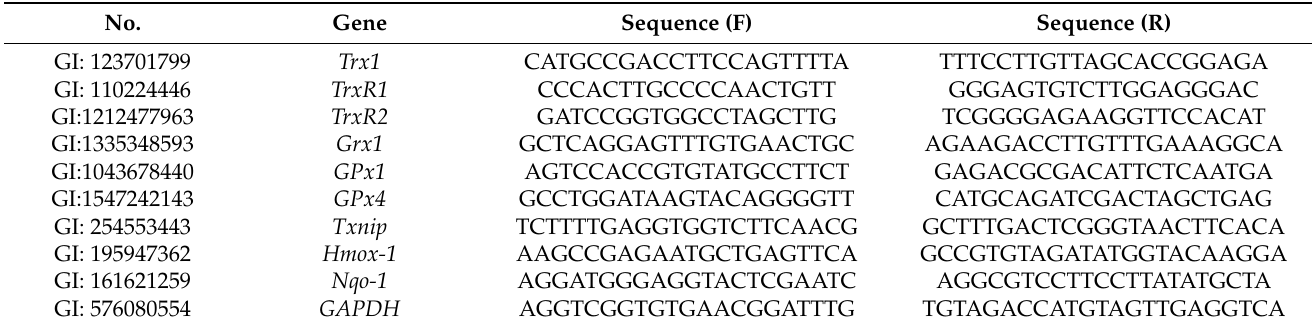
Table 1. Primer sequences used in the study with real-time quantitative PCR.